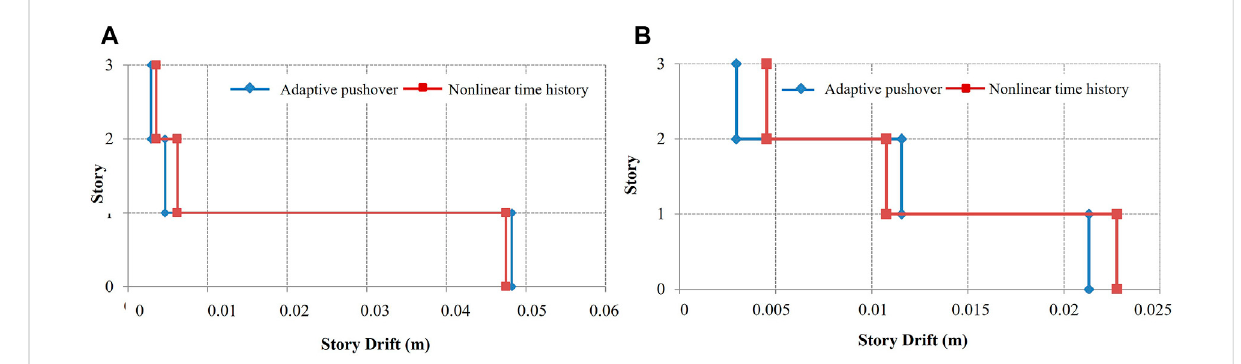
FIGURE 11 Story drifts for (A) x- and (B) y-direction.